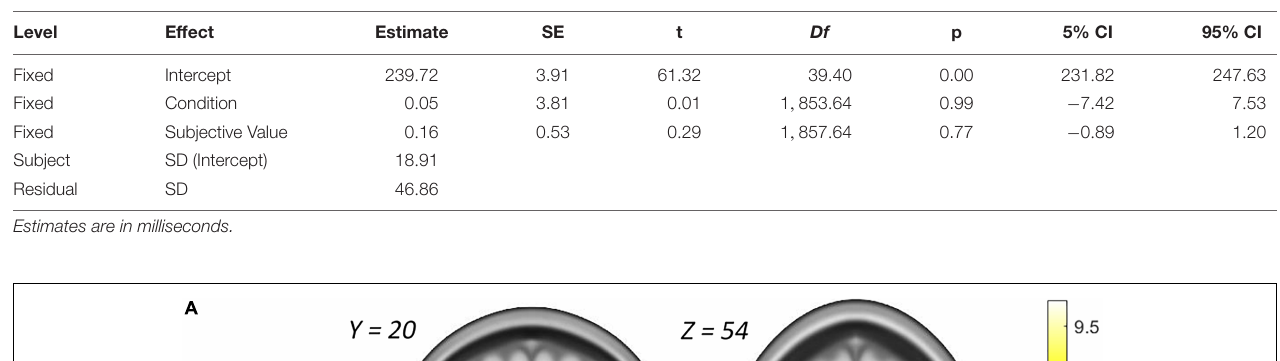
TABLE 4 | Linear Mixed Model for the effect of condition (Loss = 0, Reward = 1) and subjective value of outcome on reaction times during the anticipation phase. Subjective values of the chosen option were derived from the hyperbolic model (“see Behavioral Modeling”) ( N = 30).